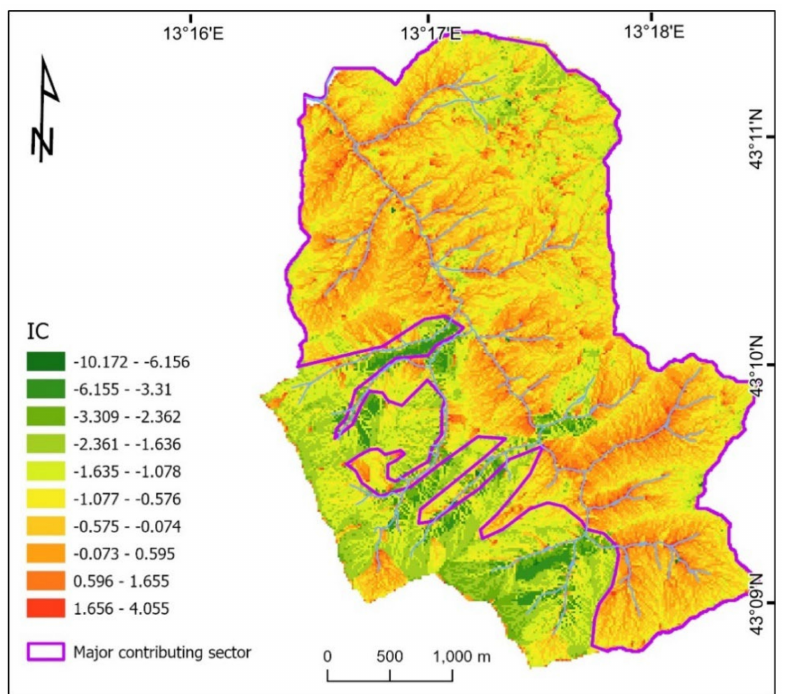
Figure 5. Map of sediment connectivity for the San Rocco